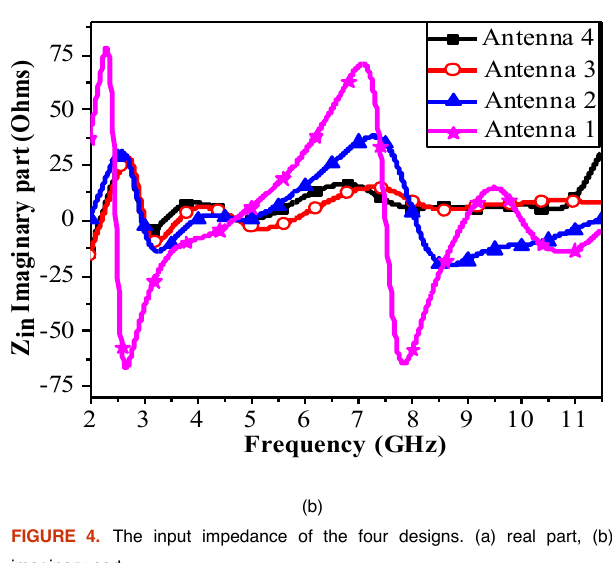
FIGURE 4. The input impedance of the four designs. (a) real part, (b) imaginary part .